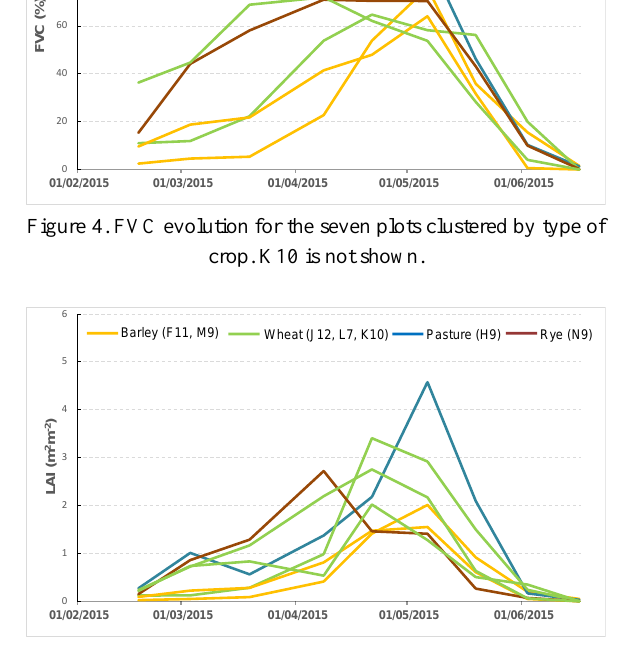
Figure 5. LAI evolution for the seven plots clustered by type of crop.